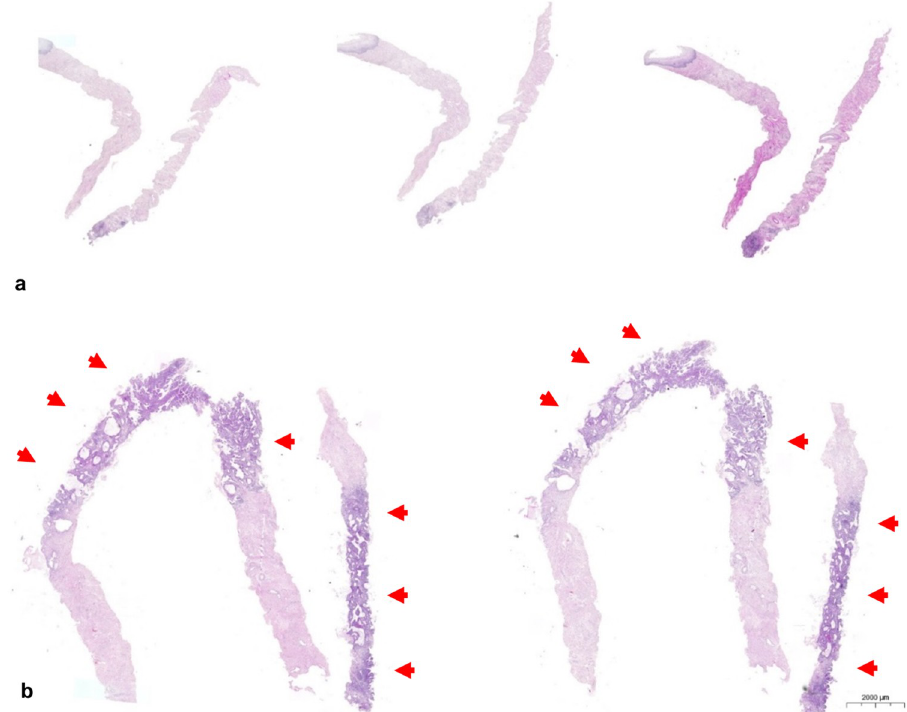
Fig 1. Histologic examination of core needle biopsies. A case representing two core needle biopsies examined using three step sections in (a). Core needle biopsy in (b) representing three cores showing tumor infiltration from 20% to 80%